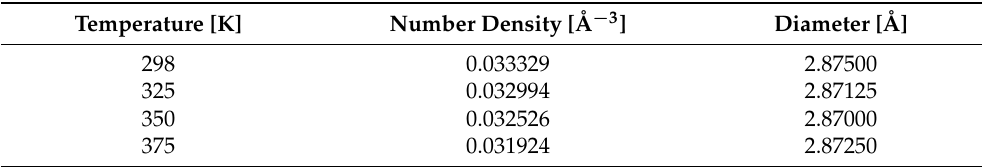
Table 1. Experimental number density of water [38] and optimal diameters of the hard sphere diame- ter for SFE calculations with the reference-modified density functional theory at several temperatures along 1 atm